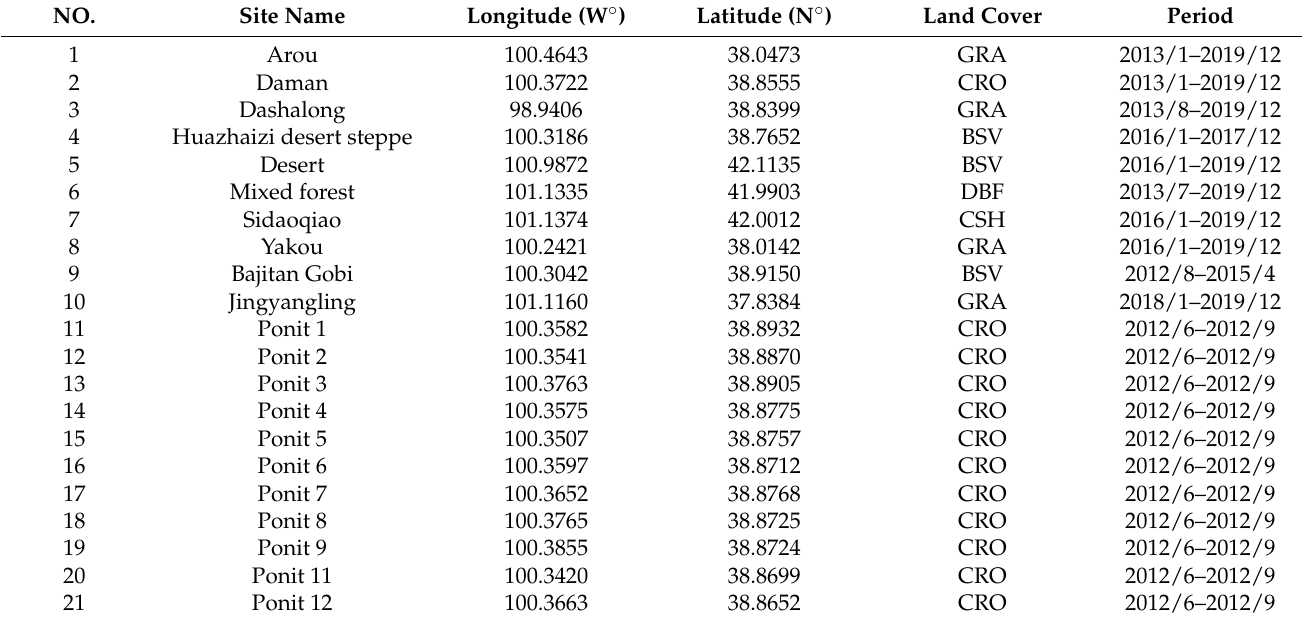
Table 1. Summary of eddy covariance flux tower sites in